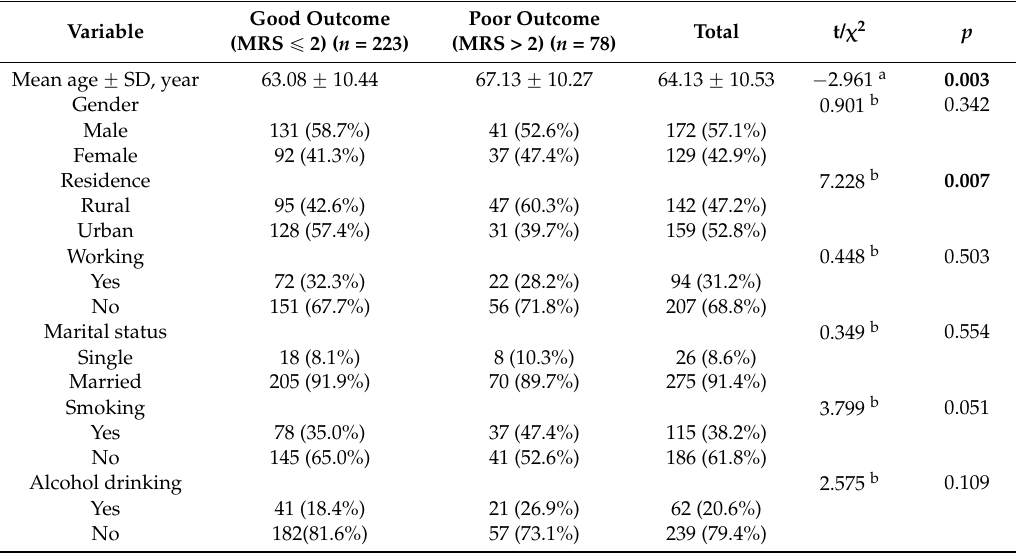
Table 1. Comparison of baseline demographic characteristics between poor outcome and good outcome at